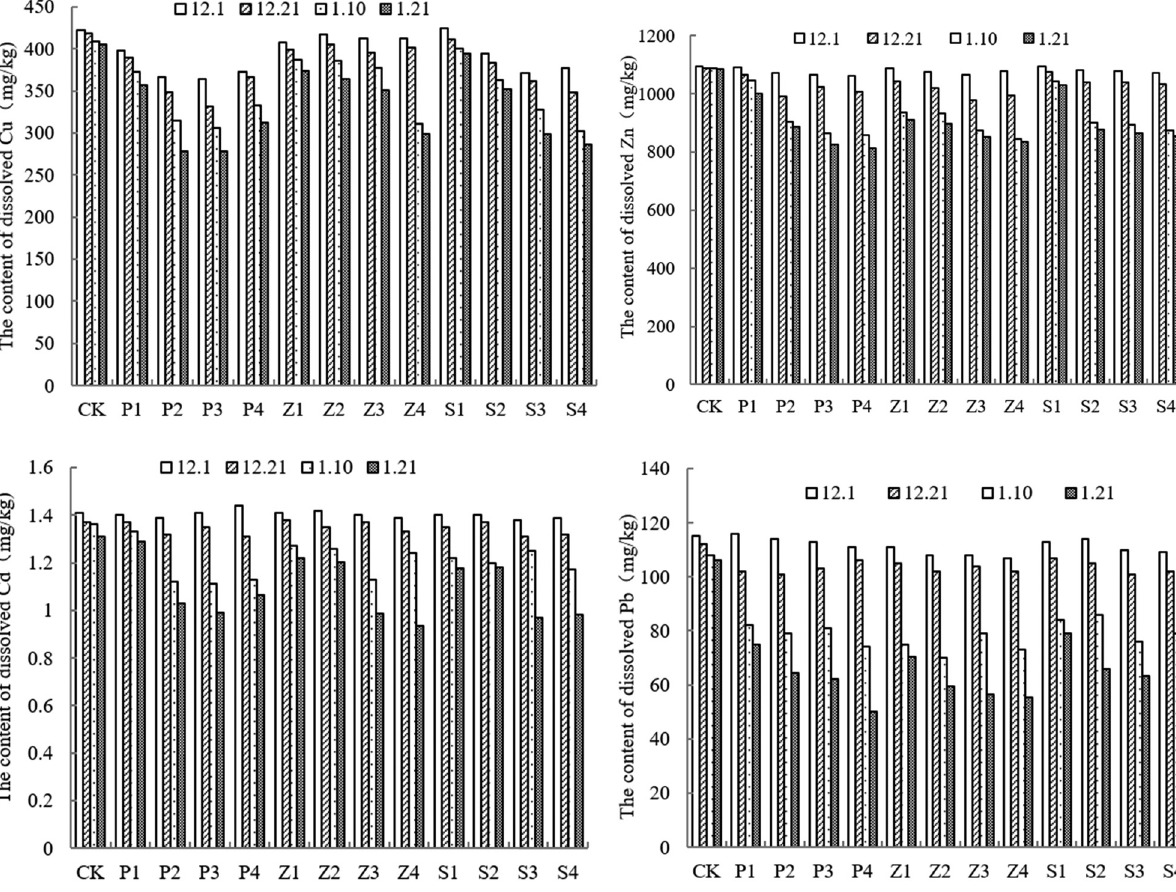
Figure 2: Changes in the content of dissolved heavy metals in the soil at di ff erent incubation